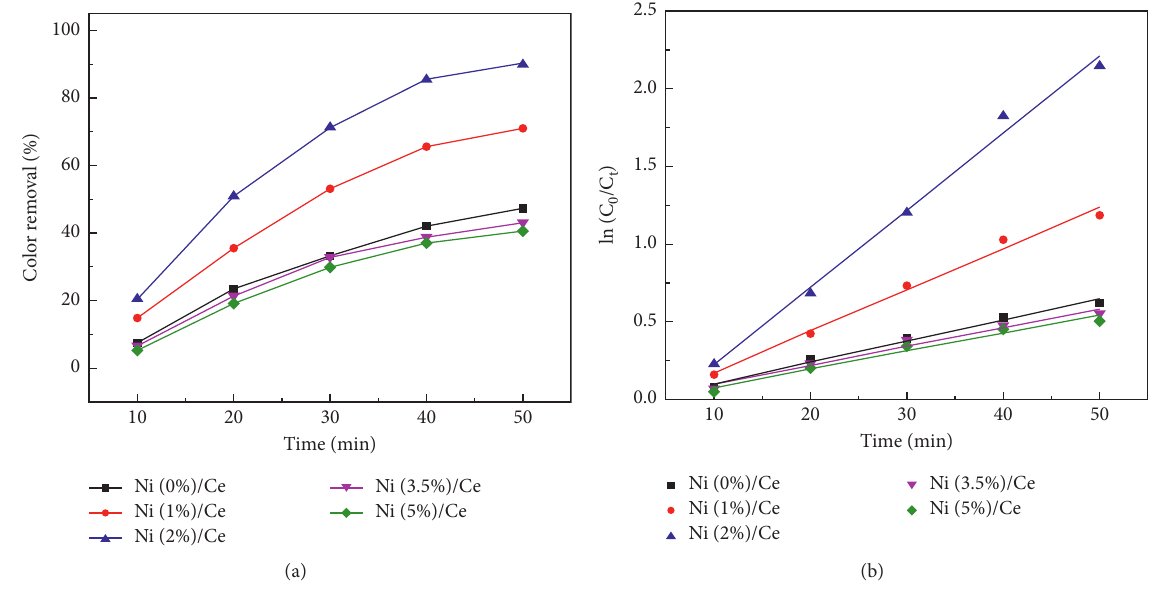
Figure 10: Electrochemical decolorization performance at Ti/SnO 2 -Sb-Ni/Ce electrodes modified with various Ni contents. (a) Decol- orization efficiency. (b) Kinetic analysis of the curves (RhB concentration: 40mg · L − 1 ; current density: 10mA · cm − 2 ; supporting electrolyte: 0.1mol · L − 1 Na 2 SO 4 ; 25 ° C). Table 5: Kinetic parameters of 40mg · L − 1 RhB in electrochemical processes by Ti/SnO 2 -Sb-Ni/Ce electrodes modified with various Ni